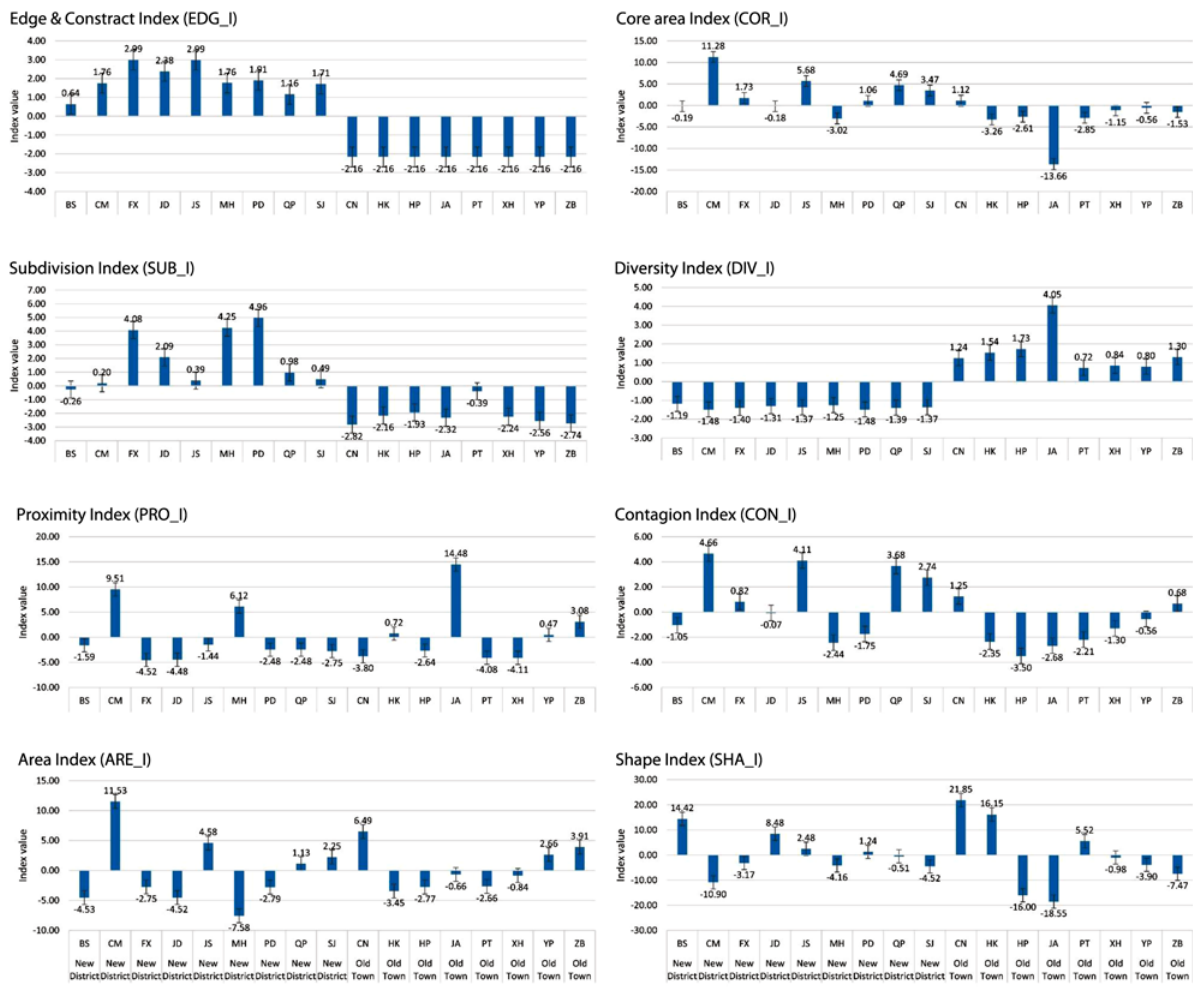
Fig. 4. Index value of each metric class by